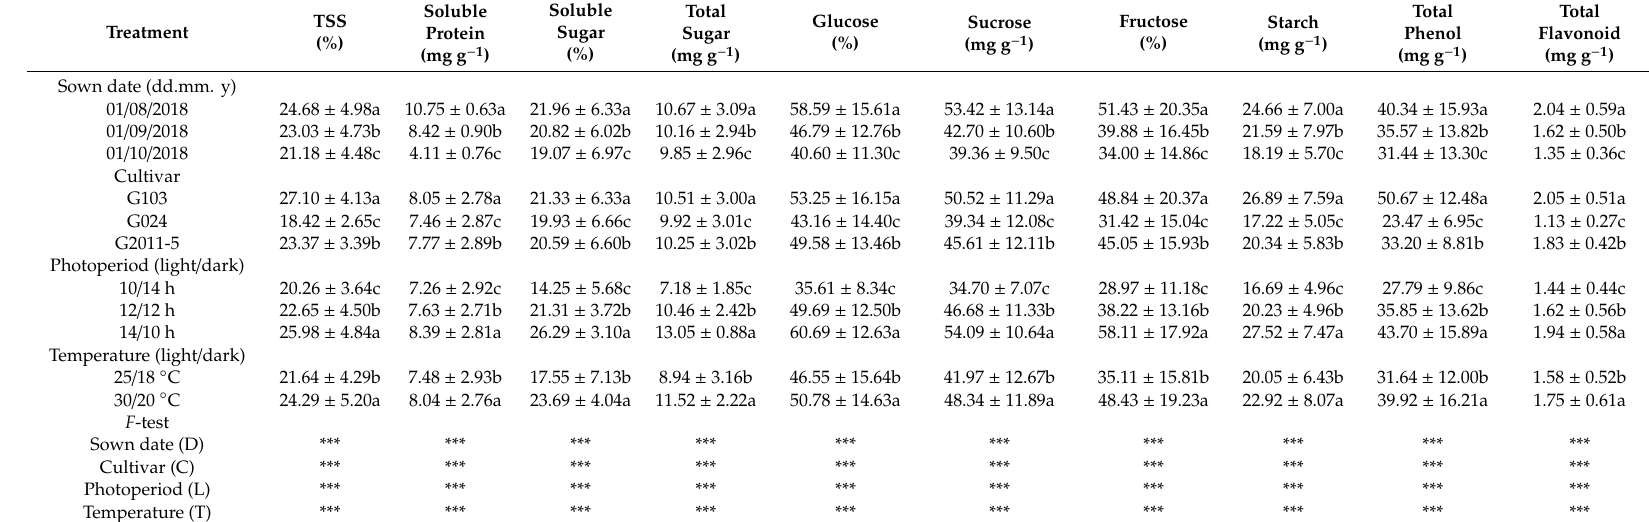
Table 3. E ff ect of sowing date, cultivar, photoperiod and temperature treatments on garlic bulb physiological and nutritive quality traits.